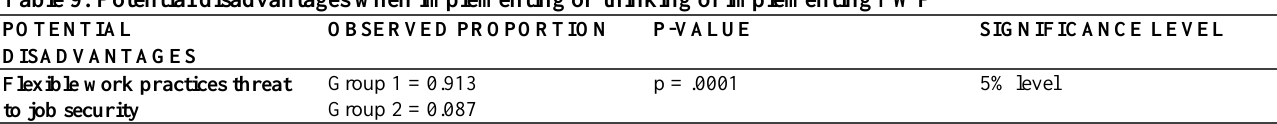
Table 9: Potential disadvantages when implementing or thinking of implementing FWP POTENTIAL